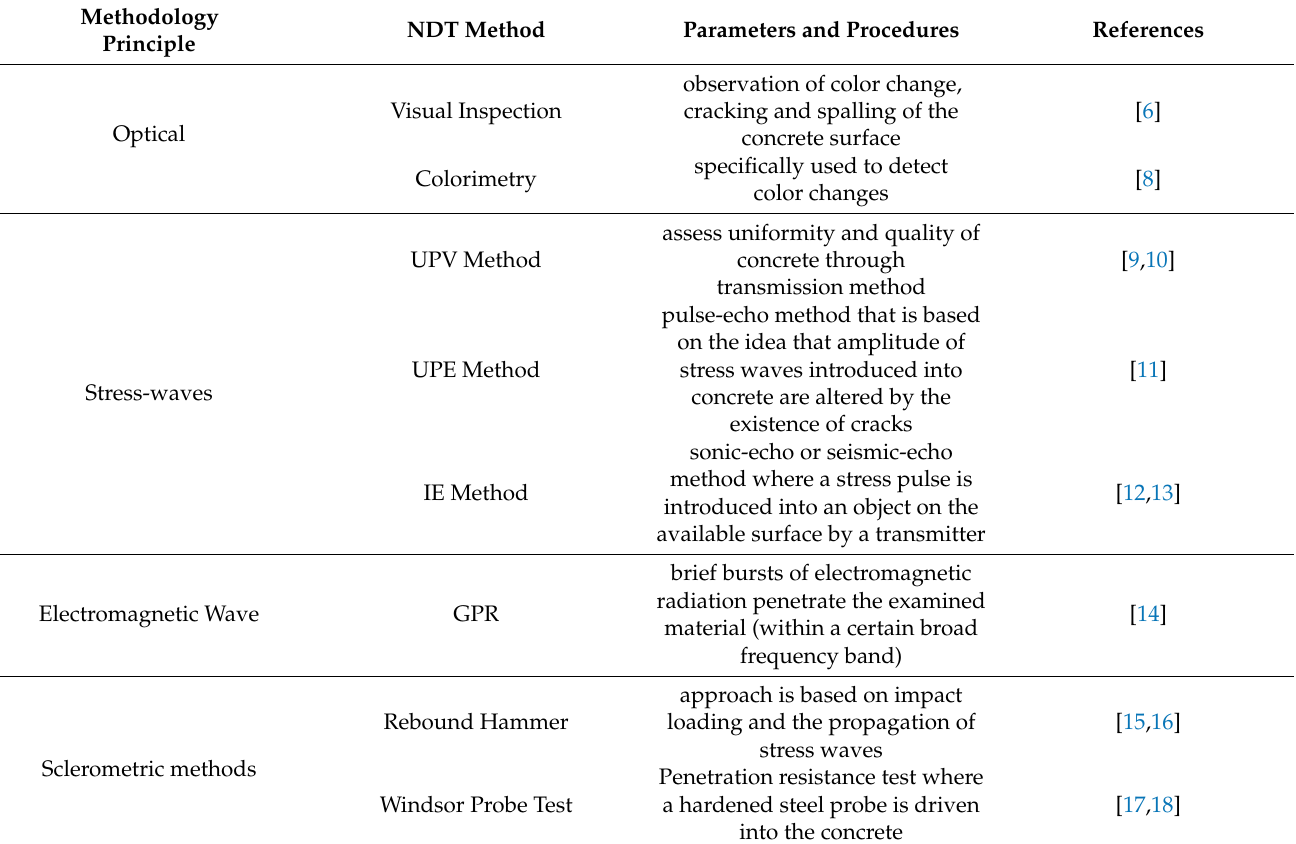
Table 1. Summary of some NDT methods for evaluation of heat-induced concrete damage from the